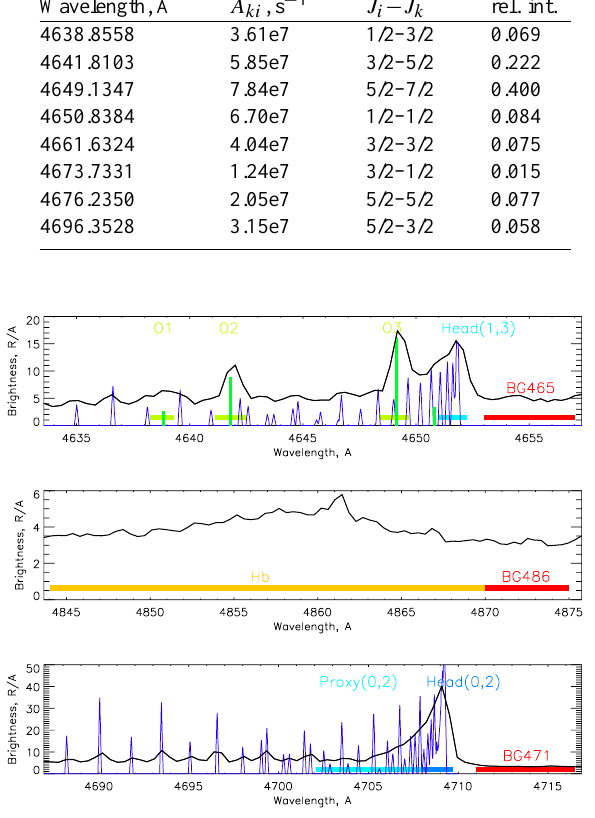
Fig. 3. Three-hour integrated spectra of the interval presented in Fig. 2. Overlaid are the synthetic spectra of the N + bands (Degen, 1977) for rotational temperature of 900K (thin blue line), and the O + lines (green bars). The horizontal bars designate the spectral intervals used to derive the intensities of the emissions – see text.